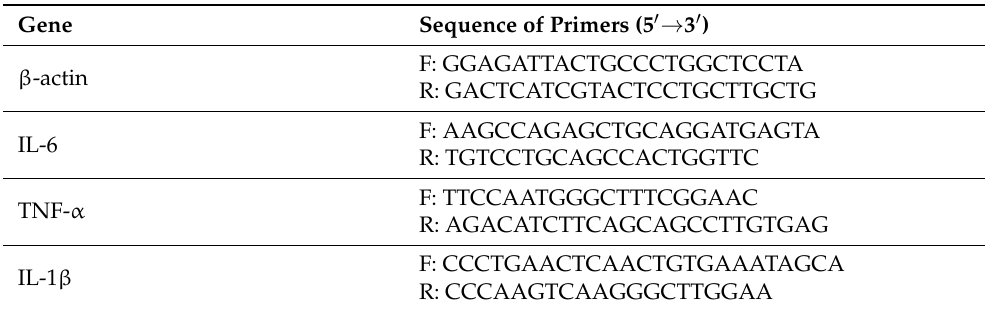
Table 1. Primer sequence for qRT-PCR in anti-inflammatory study. Gene Sequence of Primers (5 (cid:48) → 3 (cid:48)